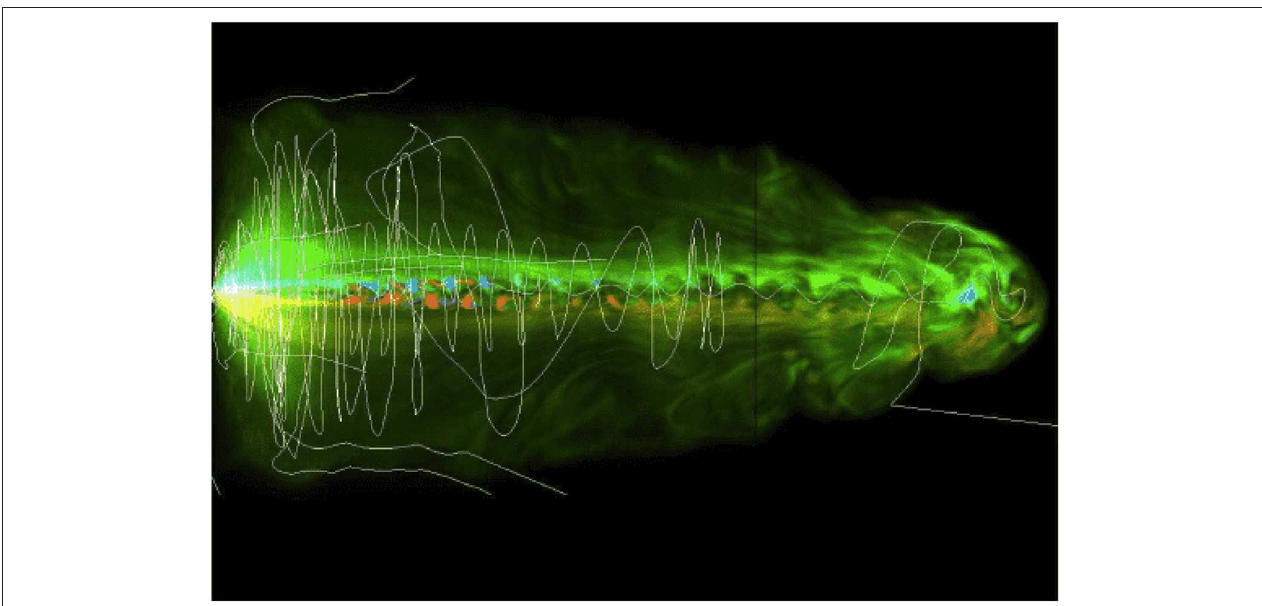
FIGURE 6 | 3D MHD simulations of a disk wind showing the toroidal velocity and magnetic field lines for a disk wind produced in the Pelletier and Pudritz (1992) model. The outflow source is the base of the corona of a Keplerian disk, shown on the left of the figure. The simulations are run on a grid extending out to 90 au along the jet axis, and 27 au on either side of the jet axis. Brightness indicates higher radiation intensity from shock-produced, forbidden line emission in the jet. The red and blue colors of the knots indicate red and blue shift due to jet rotation. Note also the recollimation of the jet half way down the flow. From Staff et al. (2015) reproduced with permission c (cid:13)